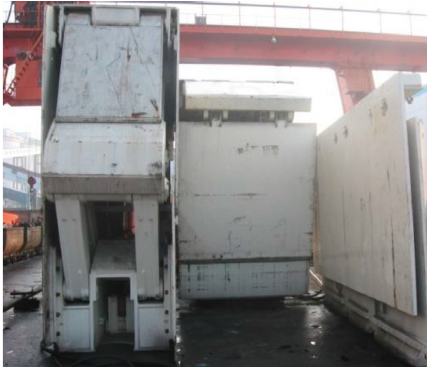
Figure 14: Template of filling support.